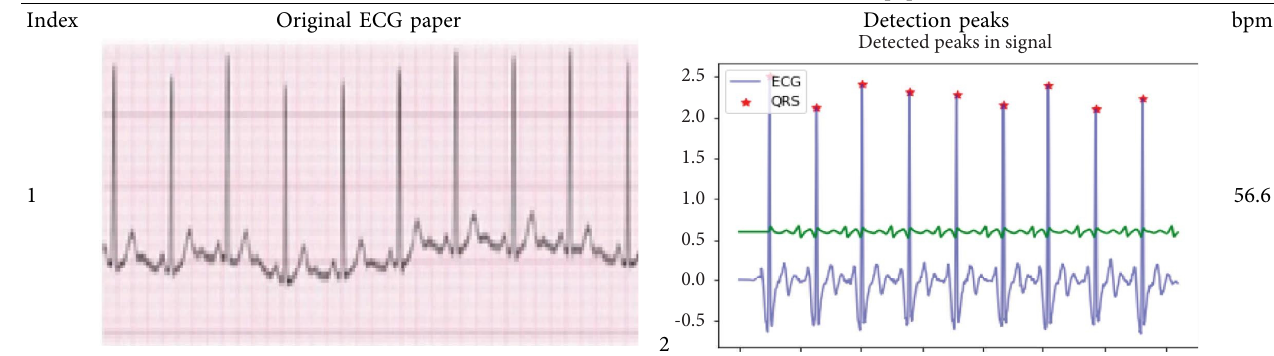
Figure 11: SMS message from Twilio platform in case of an abnormal heart rate. Table 1: Test results for some normal and abnormal ECG